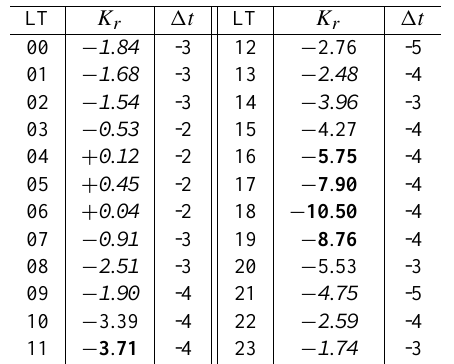
Table 6. Diurnal variation of the slope K r (in 10 − 4 per year) of the residual trend for Slough. The optimal time shift 1t (in years) between δ fo F2 132 and Ap 132 variations is given as well. Bold face figures show significant trends with a confidence level 95%, nor- mal face figures are trends with a confidence level 90%, italic face figures are trends which are not significant at the 90% confidence